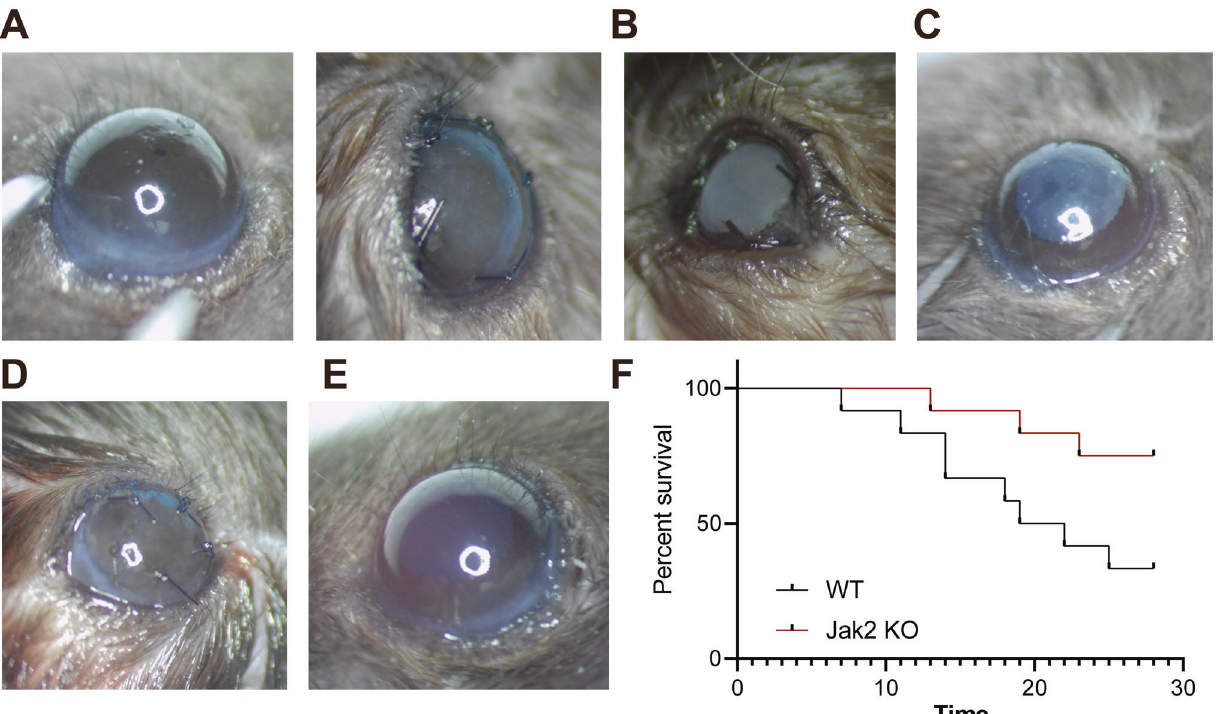
Fig. 2 JAK2 gene knockout signi fi cantly prolongs the survival time of corneal grafts. A The corneas of mice before and after the operation (The left side is the cornea of mice before the operation. The right side is the cornea of mice after the operation. B Corneal rejection that occurred in WT mice 7 days after the operation. C Corneal rejection that occurred in WT mice 14 days after the operation. D Corneas without rejection in JAK2 knockout mice 7 days after the operation. E Corneas without rejection in JAK2 knockout mice 14 days after the operation. F The survival curve of corneal grafts 28 days after operation in WT and JAK2 knockout